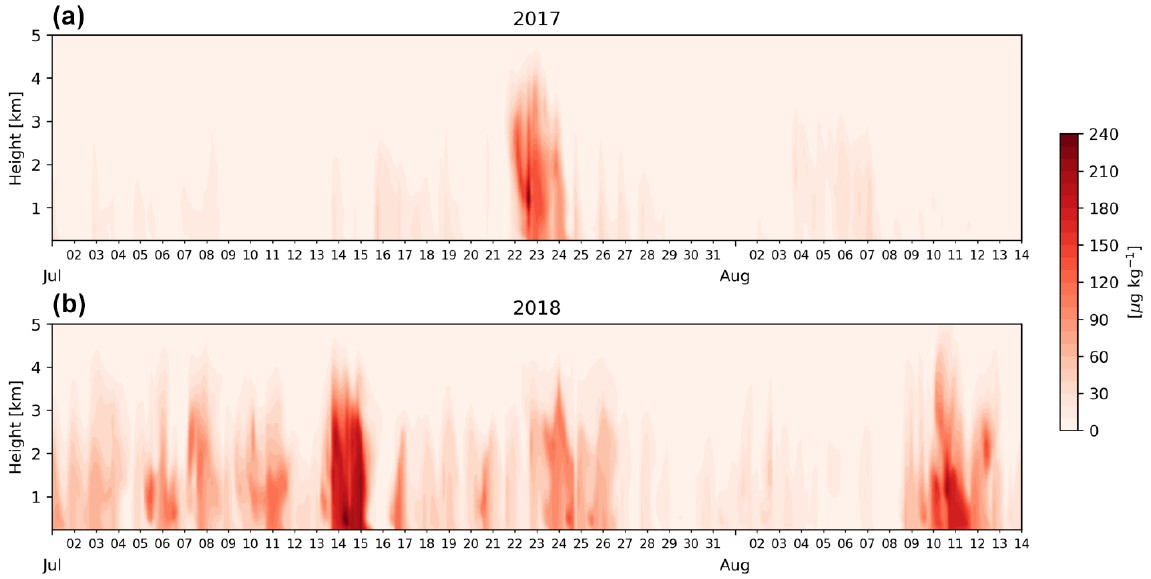
Figure 4. The 3h time series of the vertical profile of the estimated dust content from MERRA-2 for the 1 July–14 August period for (a) 2017 and (b) 2018 for the Mérida region.